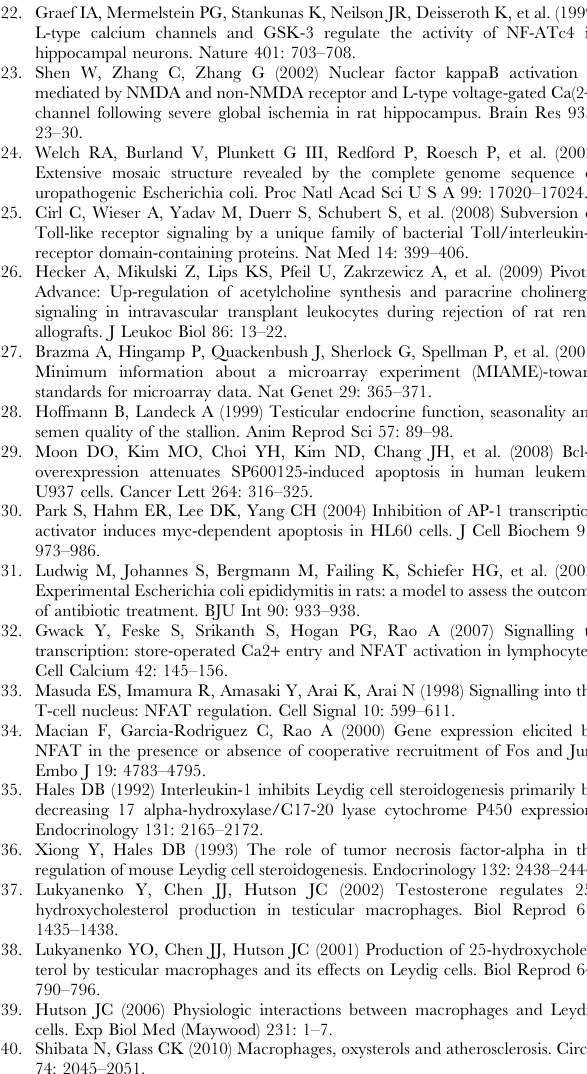
Table S2 Genes in overrepresented biological catego- ries.